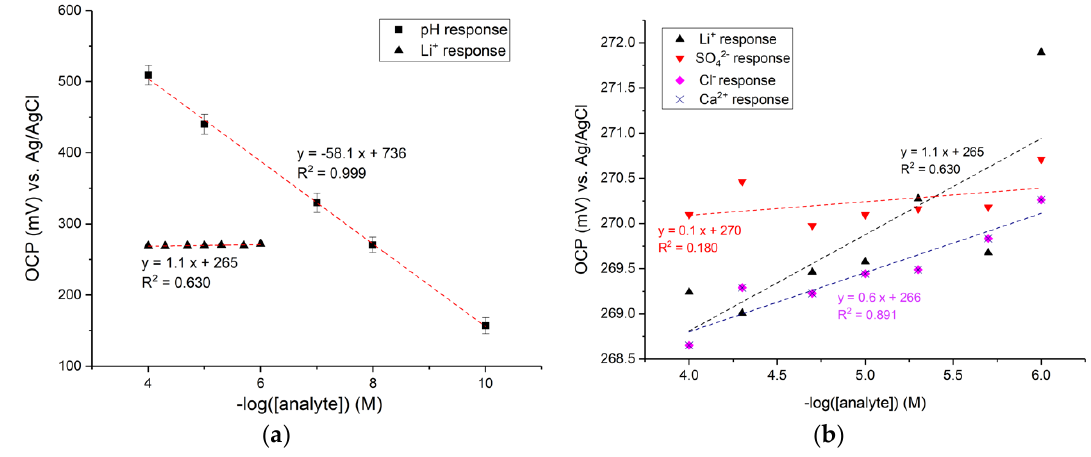
Figure 2. Experimental results of the RuOx electrode: ( a ) Open-circuit potential of the RuOx electrode in different pH buffer solutions. The error bar shows one standard deviation out of three different sets of measurement. Largest cross-sensitivity, towards lithium ions, is plotted as a comparison. Dashed lines are linear fitting through the points; ( b ) open-circuit potential of the RuOx electrode with the presence of different ions (lithium, sulfate, chloride, calcium ions) in pH 7.4 buffer. Dashed lines are linear fitting through the points.